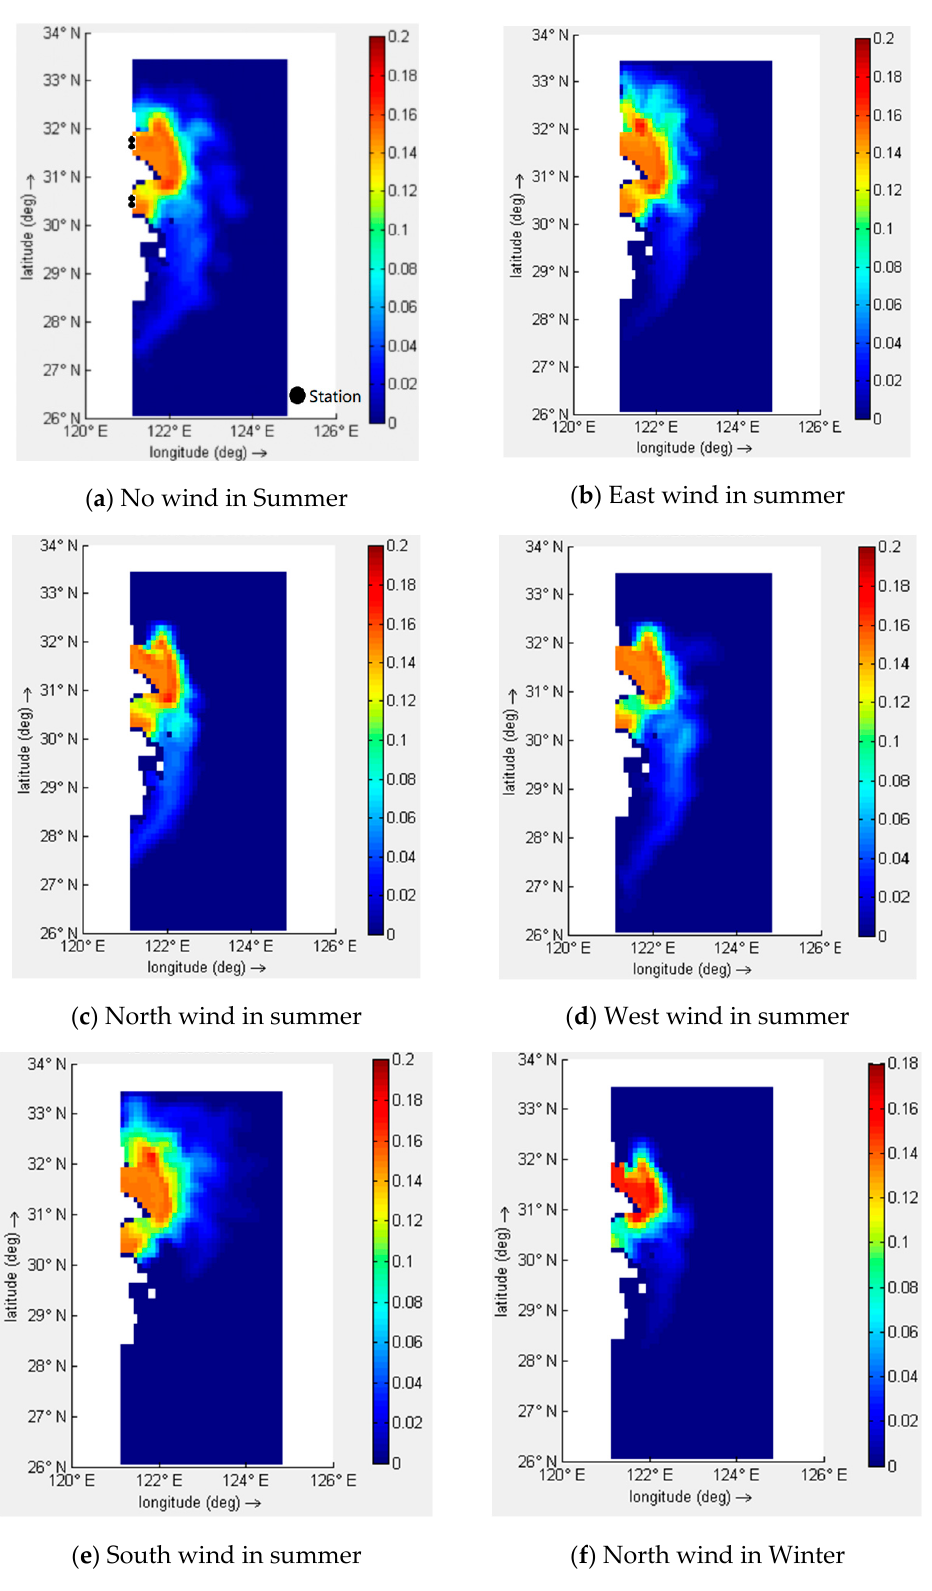
Figure 8. Suspended sediment transport at the Yangtze River Delta under no wind ( a ), east wind ( b ), north wind ( c ), west wind ( d ), southeast wind ( e ) in summer and northwest wind ( f ) in winter (Unit: g/L) [30].